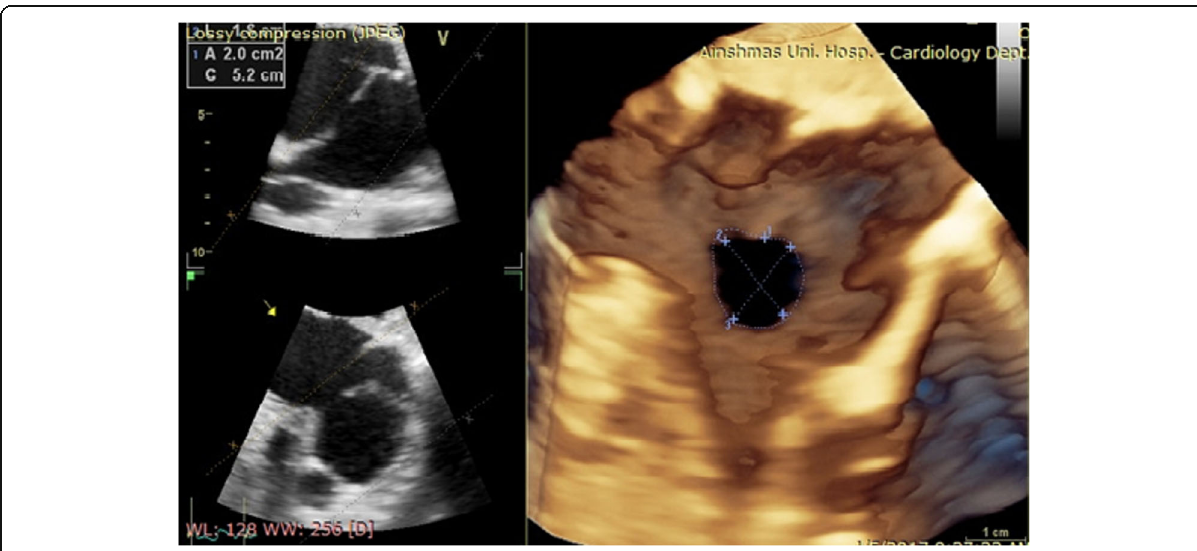
Fig. 2 3D TTE of the patient showing central moderate rounded secundum. ASD with dimensions, area and circumference measurements all visualized from RA